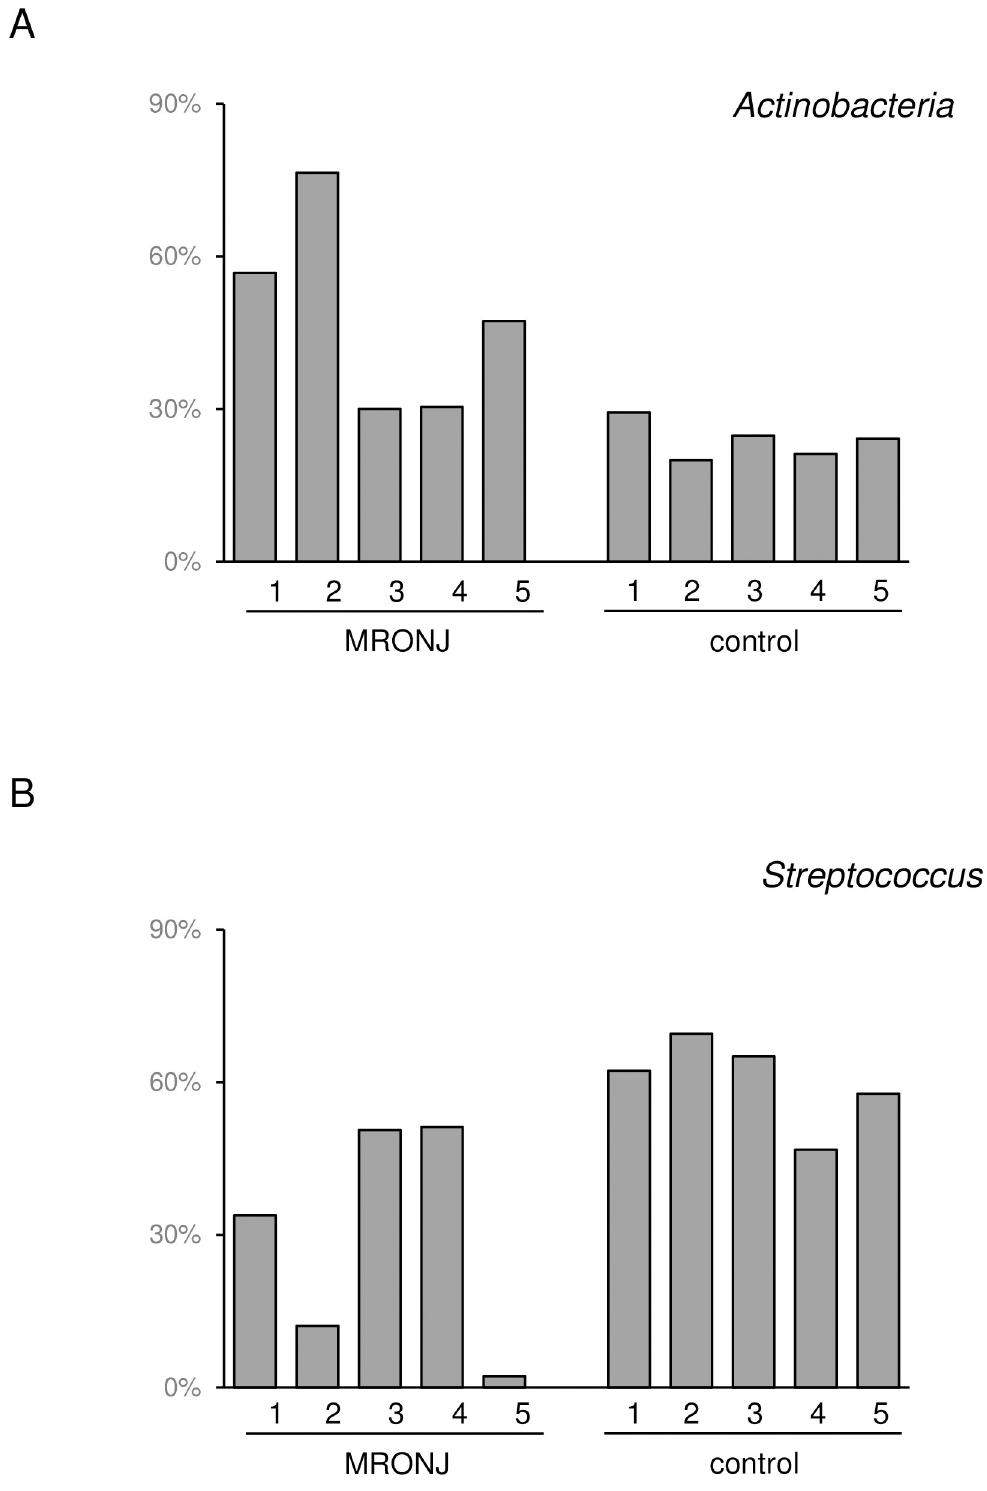
Fig 1. Relative abundance of MRONJ-associated microbes in each MRONJ case and healthy control. (A) Actinobacteria and (B) Streptococcus .